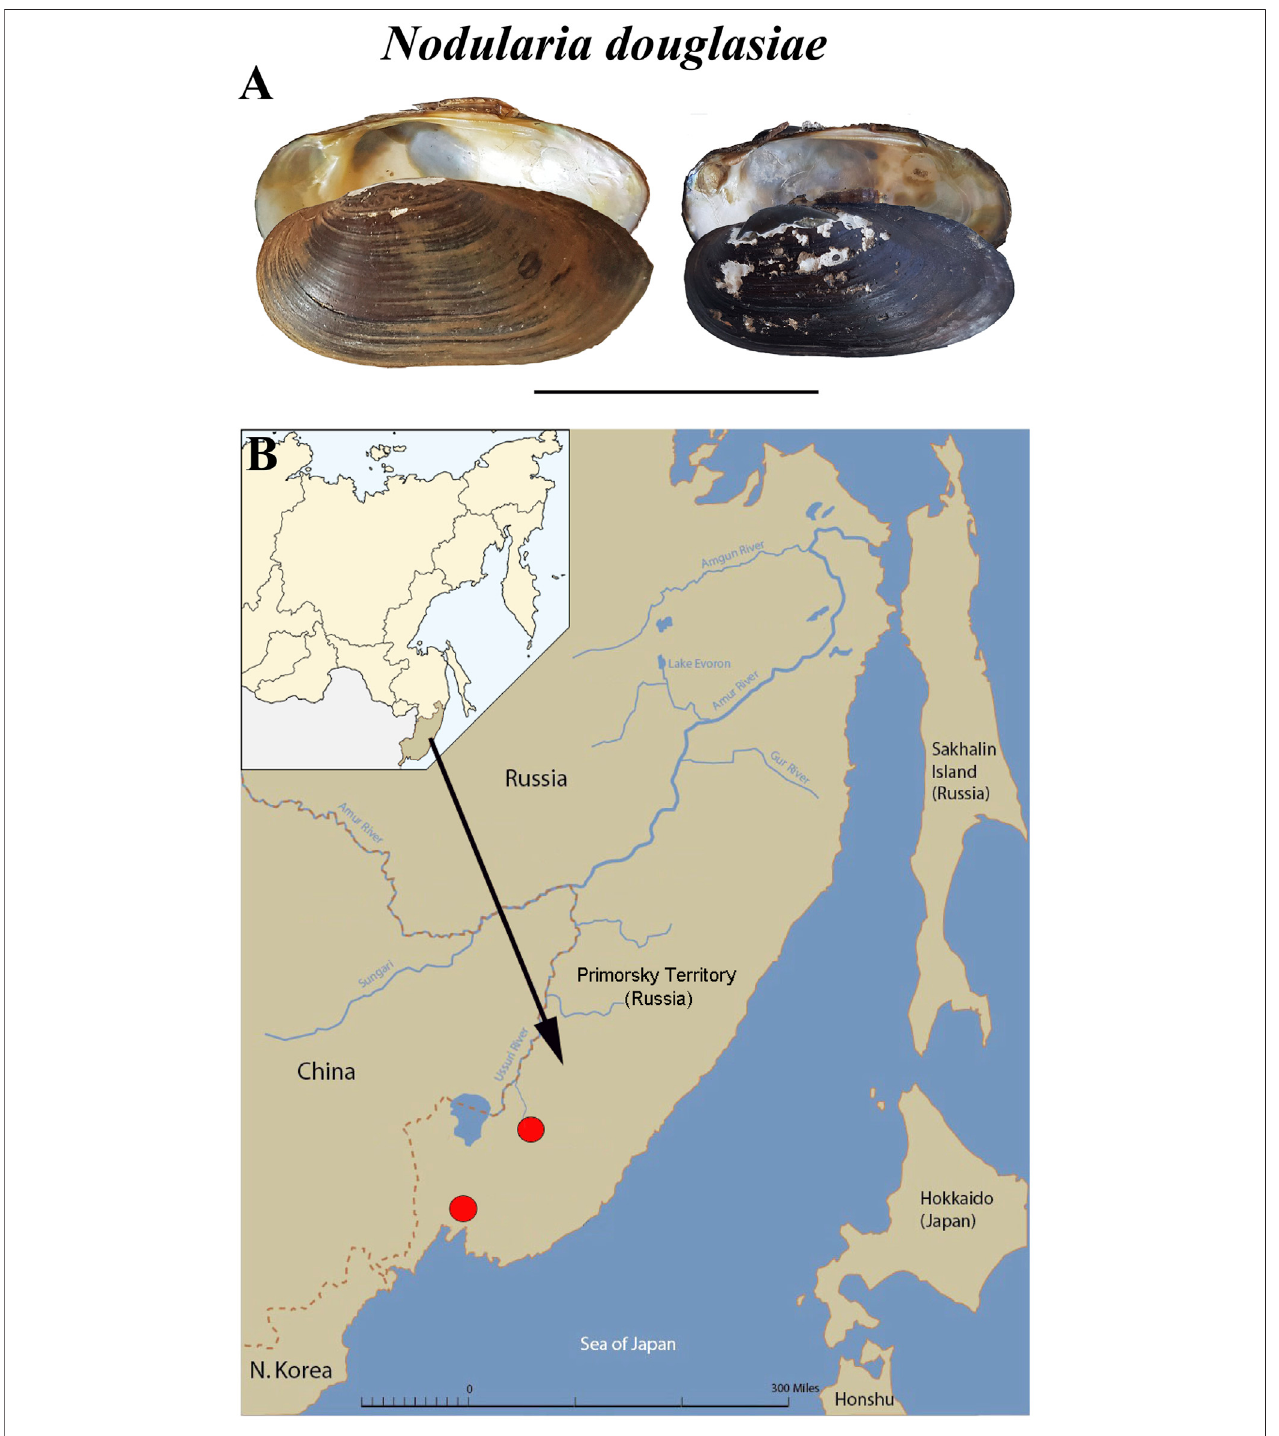
FIGURE1 | Mussel Nodularia douglasiae: mollusk shells and scheme ofthe life cycle. (A) Shells of adult freshwater bivalve N. douglasiae . Scale bar 5 cm. (B) Map of the freshwater mussel collection region. The arrow points to the material collection region (Primorsky Krai) in Russia.